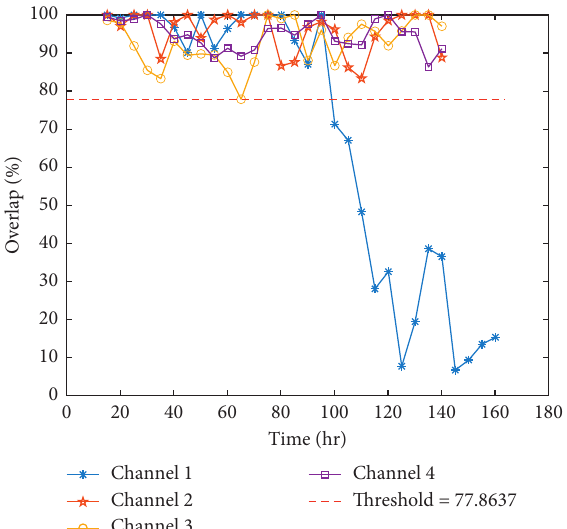
Figure 13: Temporal distribution graph of the overlaps of different